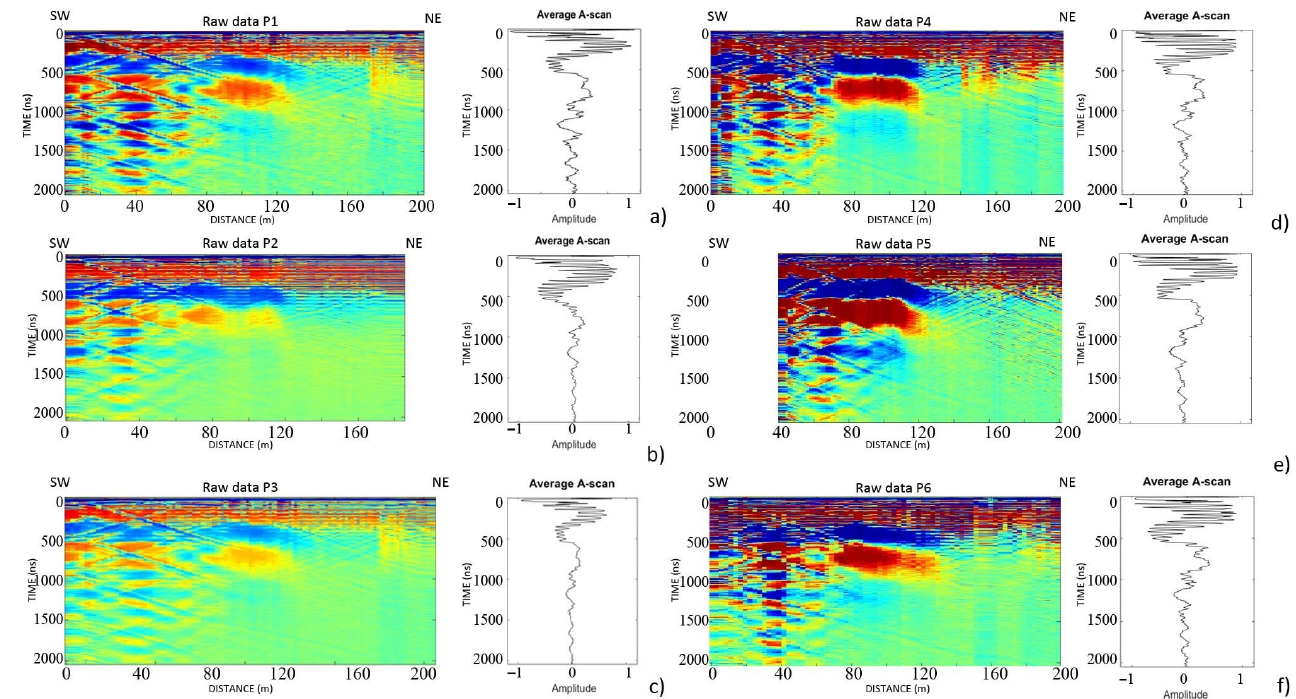
Figure 8. Raw GPR radargrams with a relative average A-scan on the right side (P1–P6, see trace in Figure 3). The subplot to the right side of each profile shows the average trace of each radargram.